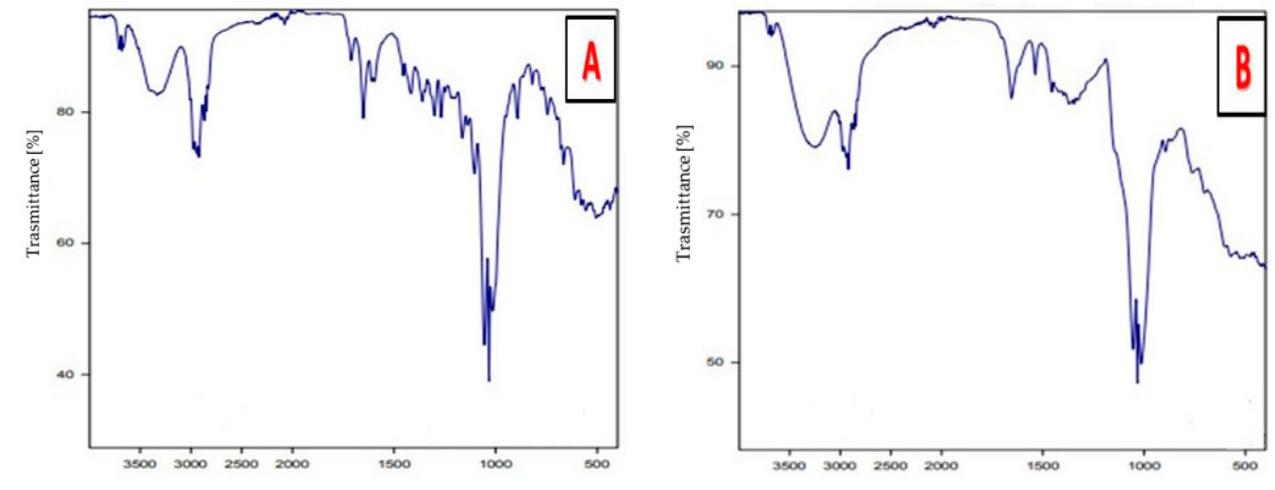
Figure 4. FT-IR of ( A ) PRD and ( B ) PRD/Zn.